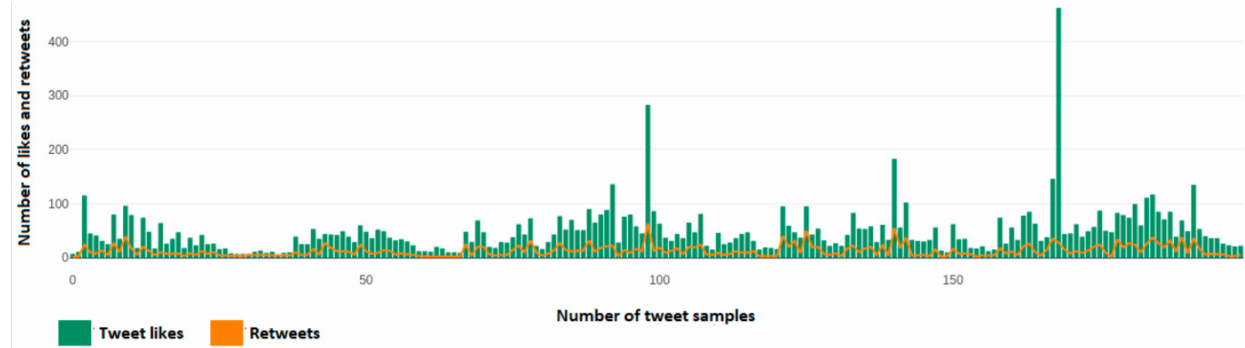
Figure 10. Number of likes and retweets per tweet for @fofigennimata (200 tweet sample).